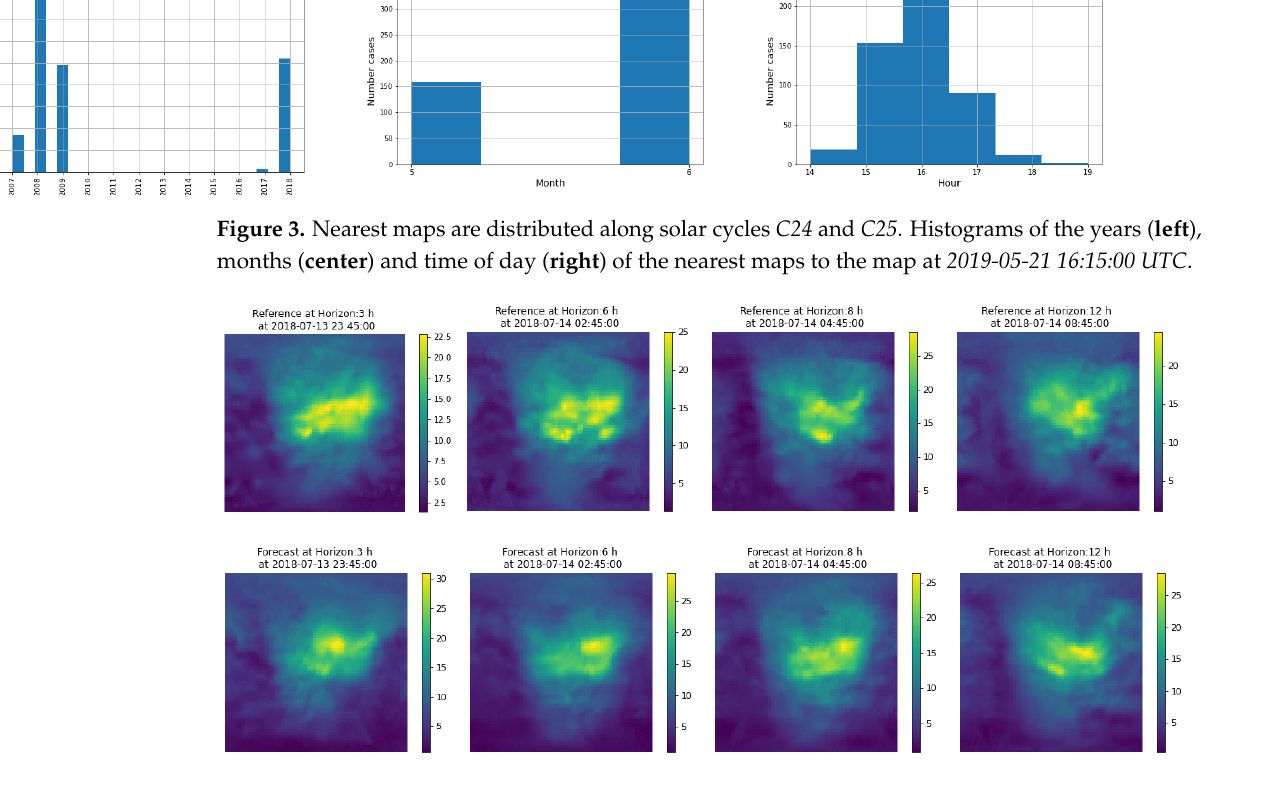
Figure 4. Selected sequence of predictions for the map at 2018-07-14 20:45:00 UT. The upper row shows the reference to 3 h, 6 h, 8 h, and 12 h horizons, the second row shows the prediction result. Note that the color bars are not at the same scale. The maps range in latitude from 90 degrees north to 90 degrees south, and in longitude from 180 degrees west to 180 degrees east. Color bars are in TEC